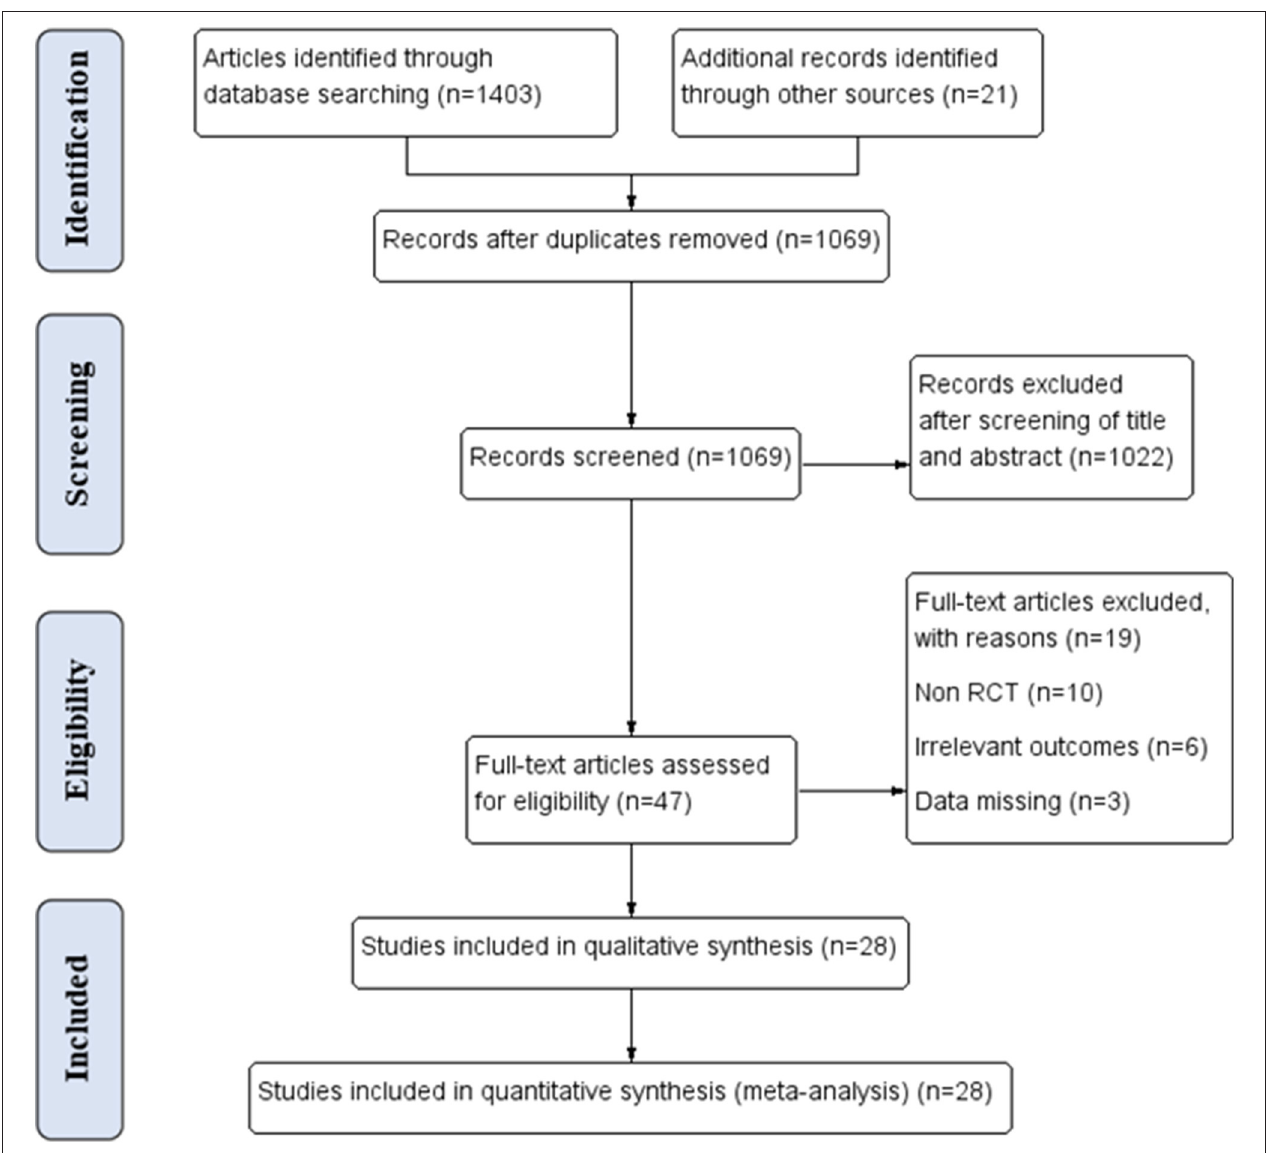
FIGURE 1 | PRISMA flow diagram of the study selection